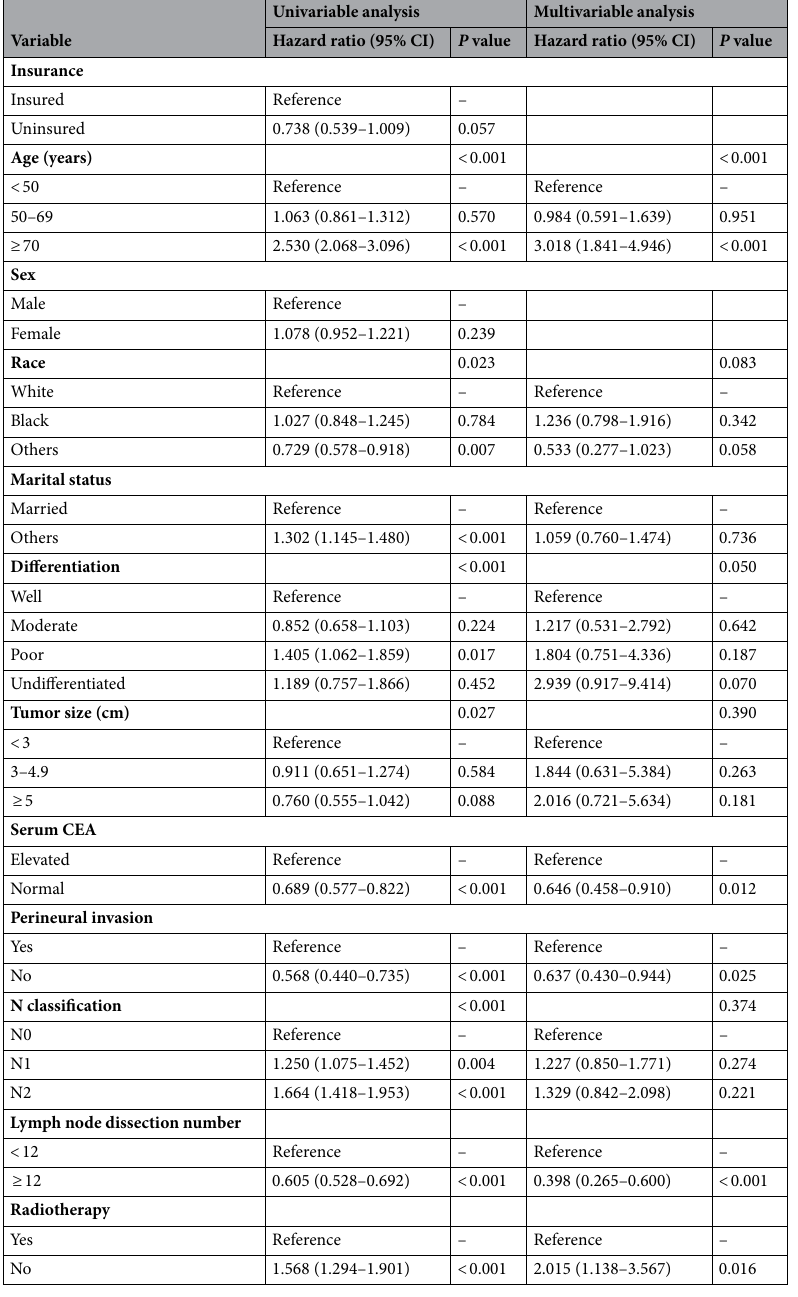
Table 2. Variables associated with overall survival according to the Cox proportional hazards regression model. CI confidence interval, CEA carcinoembryonic